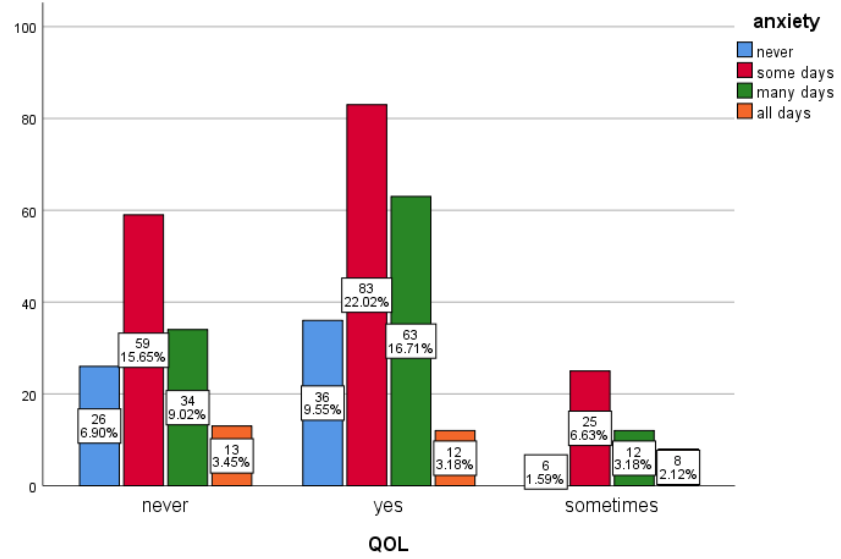
Figure 2. Anxiety level versus quality of life (QOL). Pregnant women whose quality of daily life and caring for others were affected during the pandemic answered “yes”, indicating higher anxiety levels than those who answered “never” or “sometimes” ( p < 0.001).